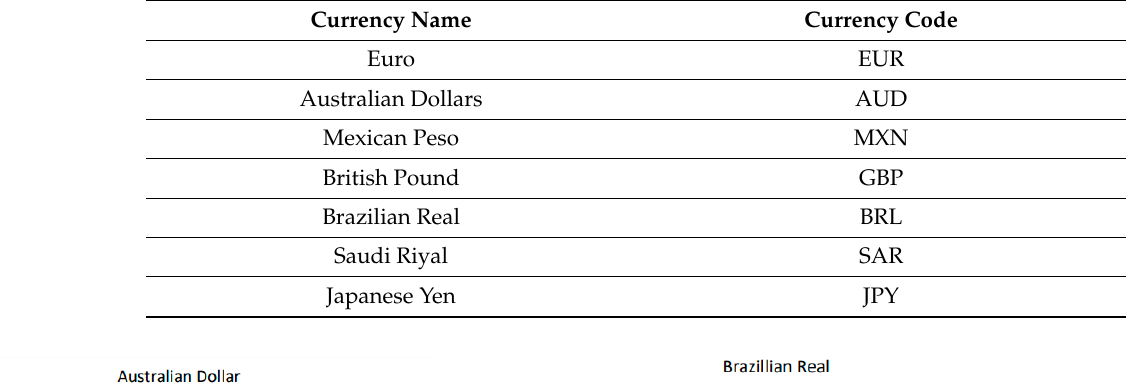
Table 2. FOREX Currencies.